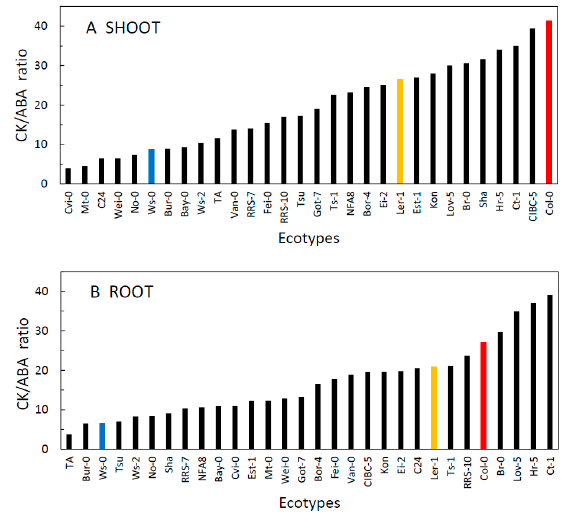
Figure 5. The ratio of total CKs to ABA in the shoot ( A ) and root ( B ) ranked from the lowest to the highest among thirty A. thaliana ecotypes grown 21d in controlled conditions. Commonly used ecotypes are marked in colour (Red = Col-0, Blue = Ws-0, Orange = Ler-1). See Table 1 for full list of ecotypes.